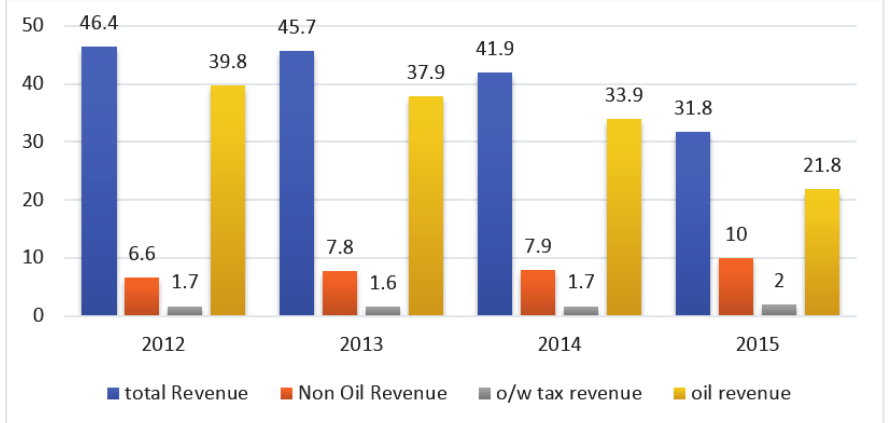
Fig. 2. Distribution of revenue in middle east countries Sources: IMF WEO; and staff